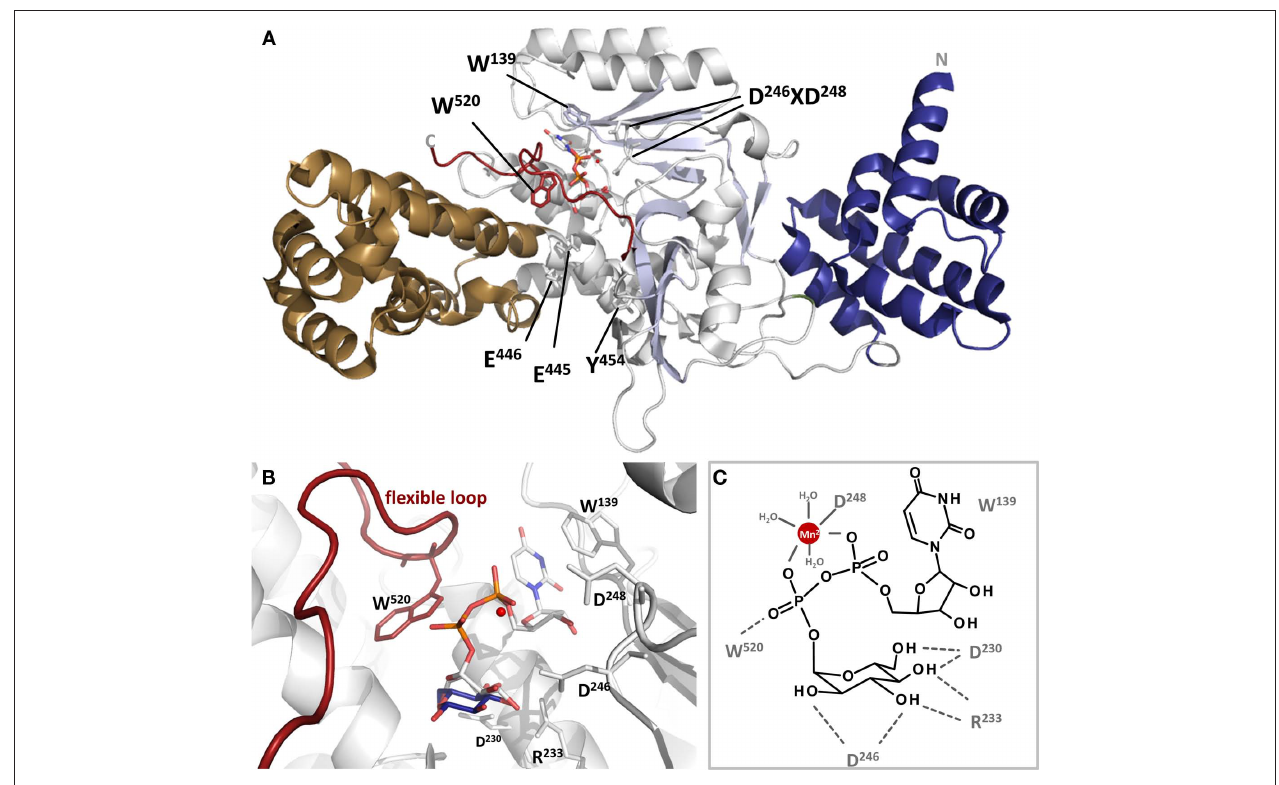
FigurE 3 | Cartoon presentation of Lgt1 crystal structure in complex with uDP–glucose and Mg 2 + (pdb code 3JSZ). (A) The N-terminal domain is depicted in blue, the central domain in gray and the protrusion domain in brown. The central beta sheet is shaded in light blue. UDP–glucose is shown in sticks and Mg 2 + as a red sphere. The flexible loop region is highlighted in dark red. Aspartic acid residues of the DXD-motif, Trp-520 of the flexible loop, Trp-139 stacking the base are shown in sticks. (B) Magnified view on the catalytic site of Lgt1 as in (A) with intact UDP–glucose (white)